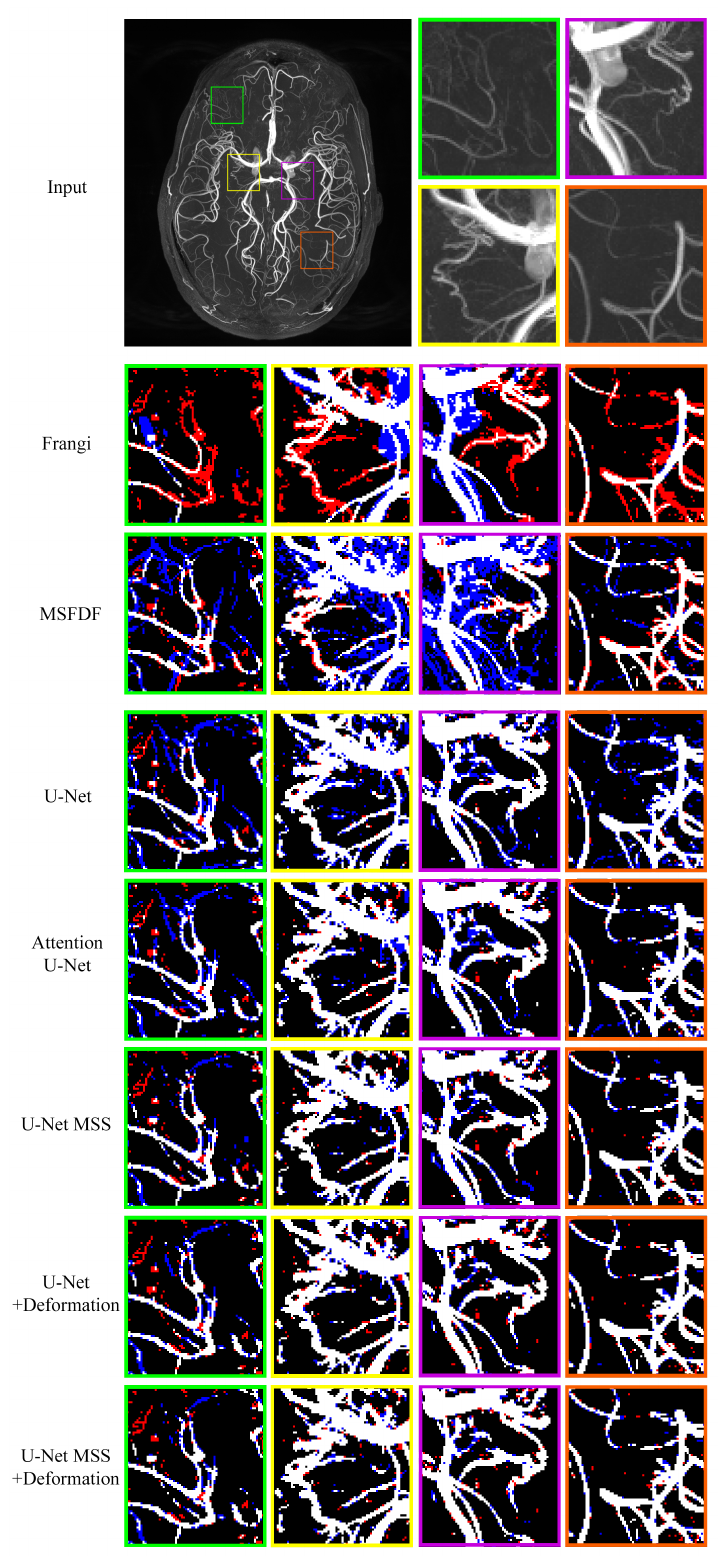
Figure 4. Comparisons of different non-DL and DL methods with the maximum intensity project (MIP) of the input volume. Red indicates false negative and blue indicates false positive (MSFDF: multi-scale Frangi diffusion filter, U-Net MSS: U-Net multi-scale